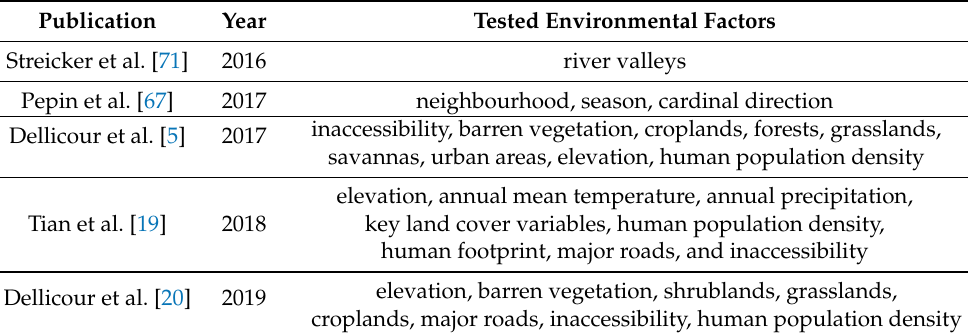
Table A2. Overview of continuous phylogeographic inference studies that assess the relevance of environmental